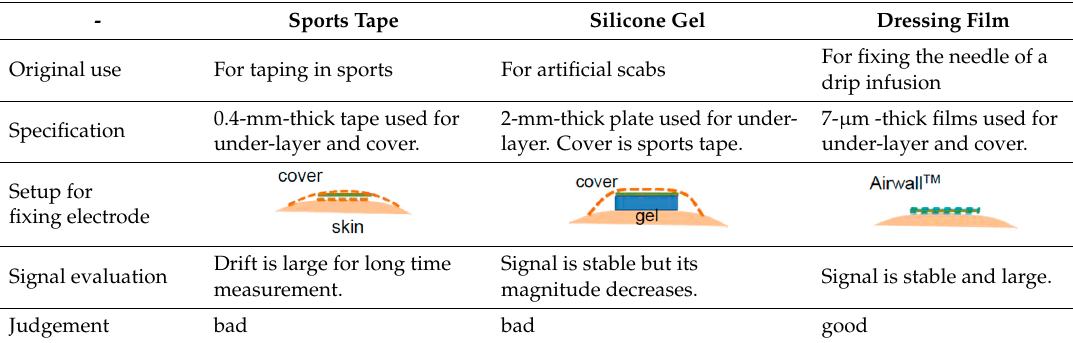
Table 1. List of tapes tested for fixing the electrodes.